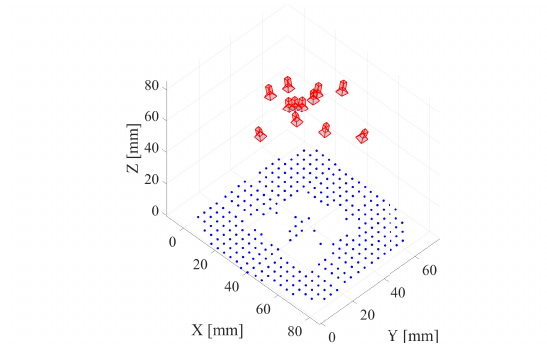
Figure 6. Bundle configuration for the close-range data set 1. Cameras are shown in red, points are colored in blue.